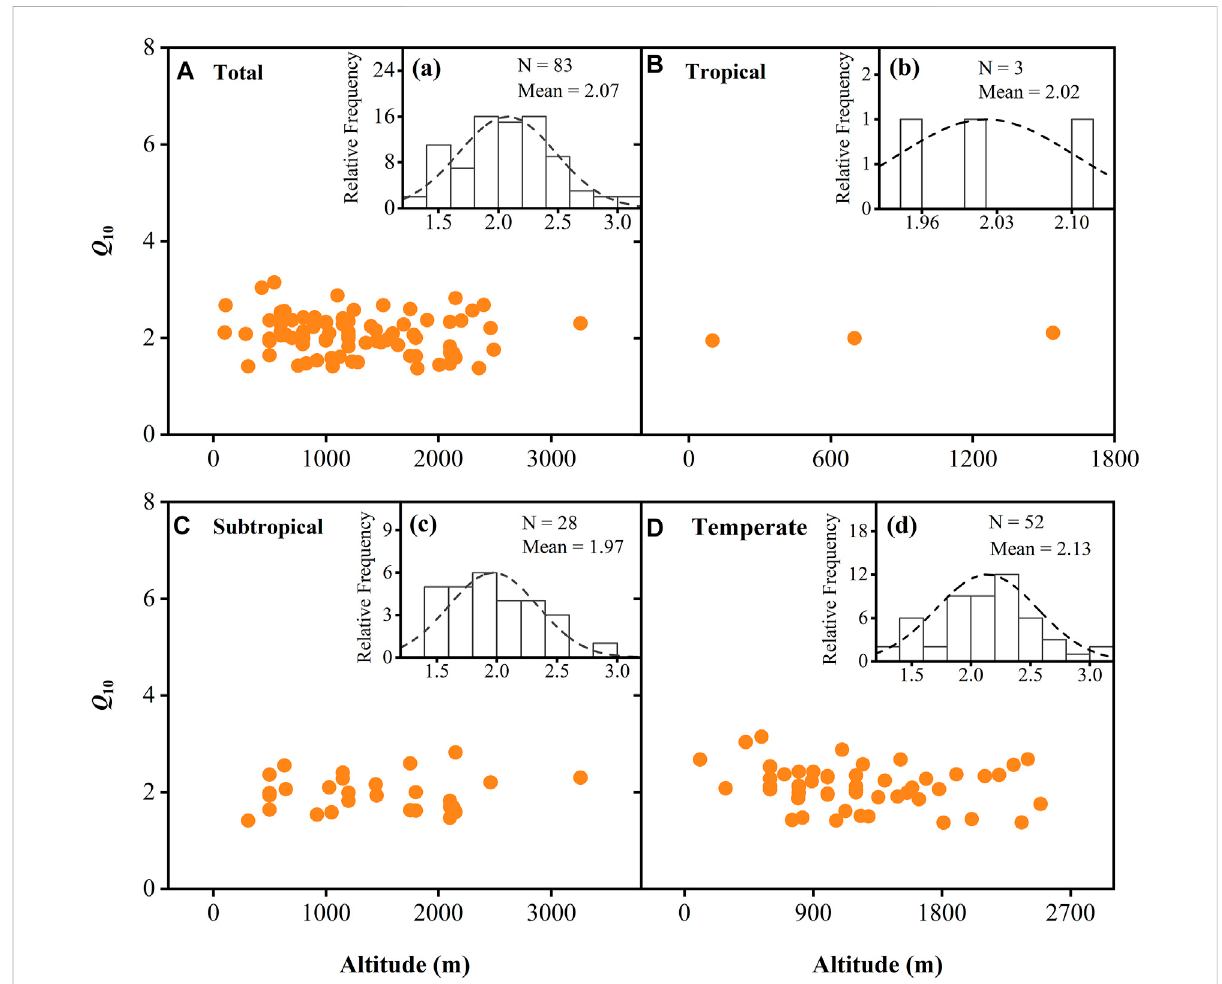
FIGURE 4 Variation in temperature sensitivity ( Q 10 ) of soil organic matter decomposition with altitude in different climatic zones. (A) Trends in Q 10 values withaltitudeonaglobalscale; (B – D) Trendsin Q 10 contentwithaltitudeintropical (B) ,subtropical (C) ,andtemperateregions (D) ,respectively. (A – D) Frequency distribution of Q 10 in the corresponding regions,